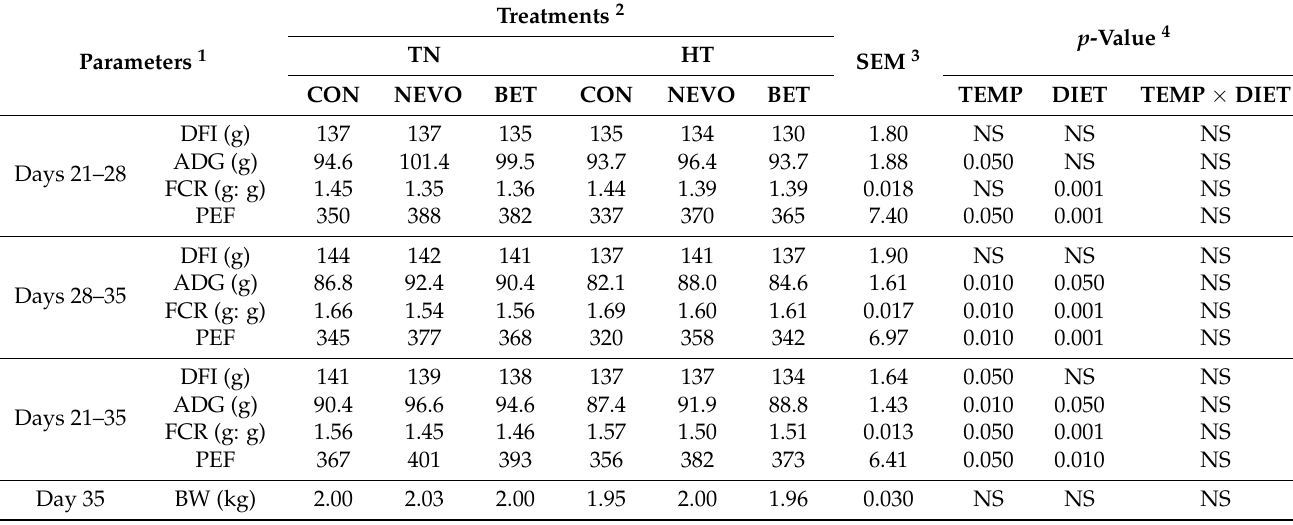
Table 2. Effects of the treatments on performance parameters of broiler chickens during finisher phase.